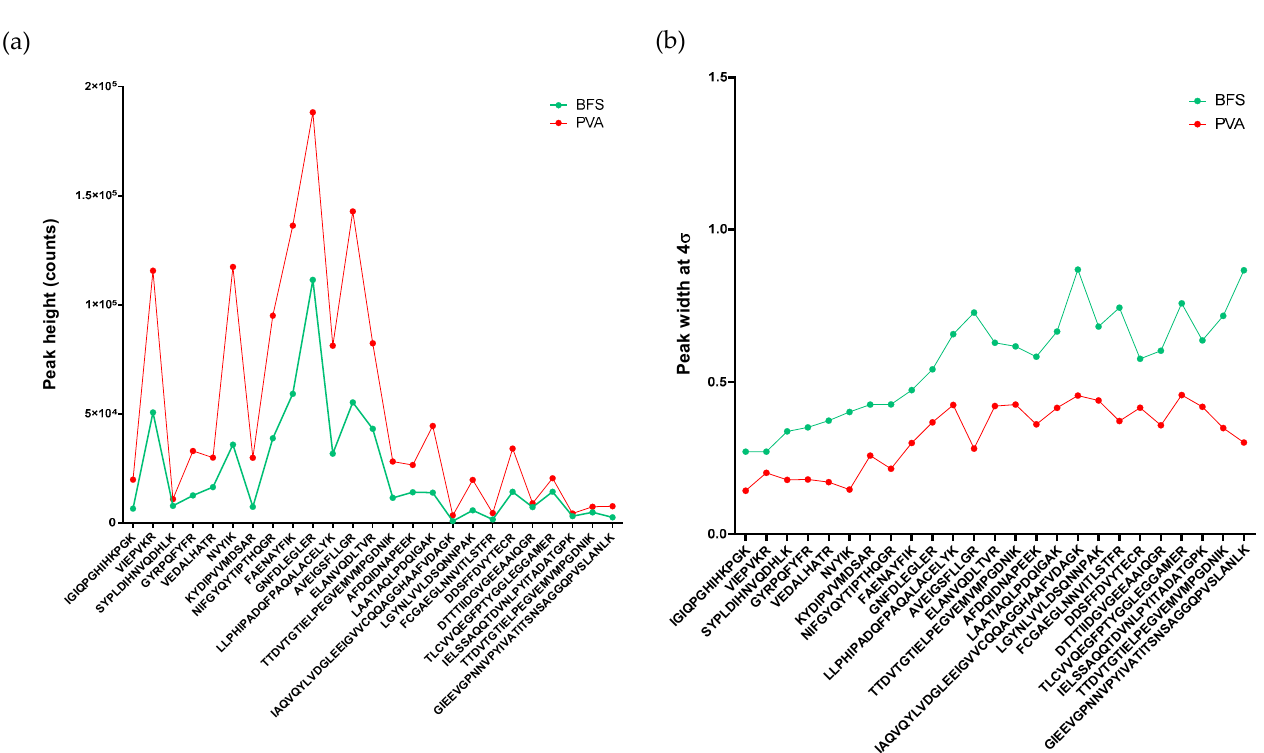
Figure 1. ( a ) Comparison of peak intensities and ( b ) peak widths at 4 σ of 25 random peptides extracted from E. coli digest throughout the migration window and analyzed using both BFS capillary and neutral coated PVA capillary.